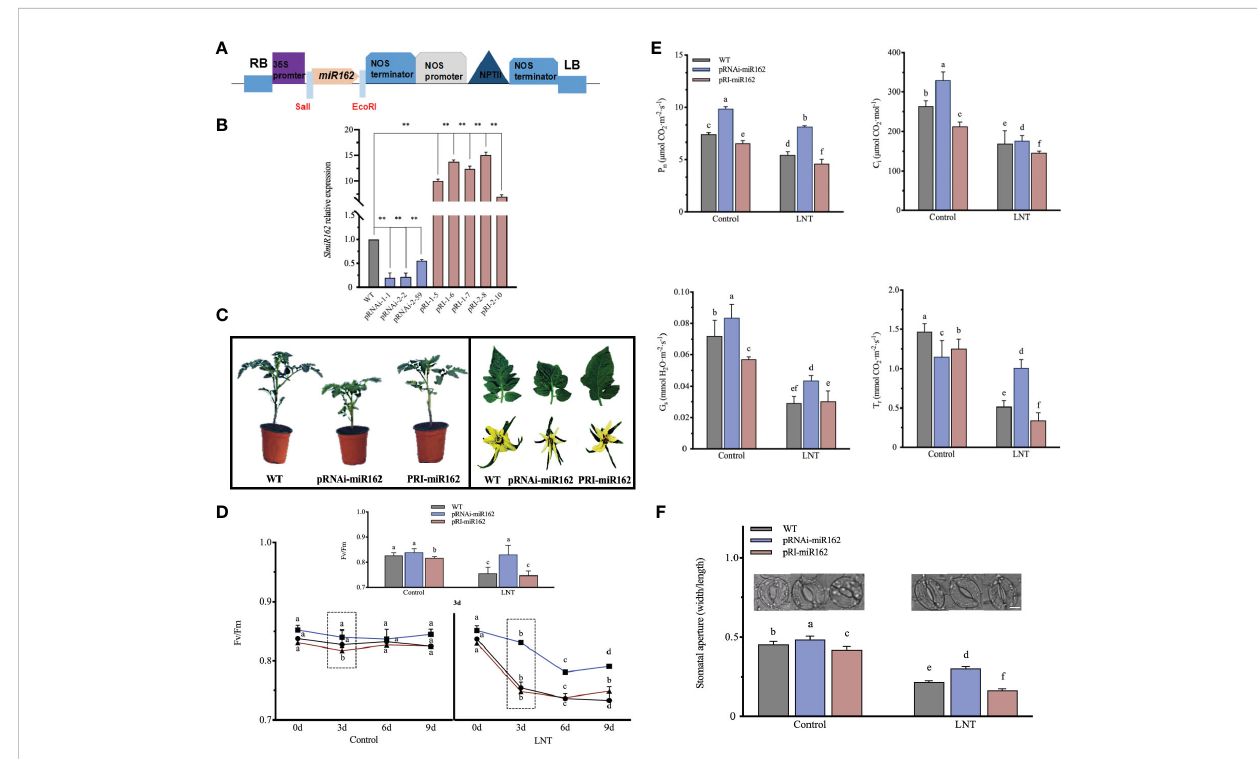
FIGURE 1 Photosynihetic effects of mR162 in response to LNT stress in tomato. (A) Diagram of miR162 recombinant plasmid. NPTIII is the marker gene with kanamycin resistance on pRI101-AN vector. (B) Quanitative realime PCR analysis of miR162 in WT and transgenic lines. Data are mean and standard error offour independent experiments (n = 4), **P < 0.01 according to the t-test. (C) Morphological characterization of miR162 transgenic tomato plants (6-week whole plants, leaves, and fl owers). (D) Maximum photochemical e fi ciency of photosystem II (Fv/Fm) in miR162 transgenic lines during the nine-day LNT stress treatment. (E) Stomatal parameters of mIR162 transgenic lines under LNT stress: net photosynthetic rate ( Pn ); intercellular Co2 concentration ( CI ); stomatal conductance ( Gs ): and transpiration rate ( Tr ). (F) Stomatal aperture and phenotype of miR162 transgenic tomato plants. Data are mean and standard error offour independent experiments (n = 4) with at least 50 individual stomata measured for each replicate. Scale bar = 5 mm. Control: 25°C/15°C, LNT stress: 25°C/15 (day/night temperature) Data are mean and standard error offour independent experiments (n = 4). Lowercase letters indicate signi fi cant differences at P< 0.05 according to Tukey's